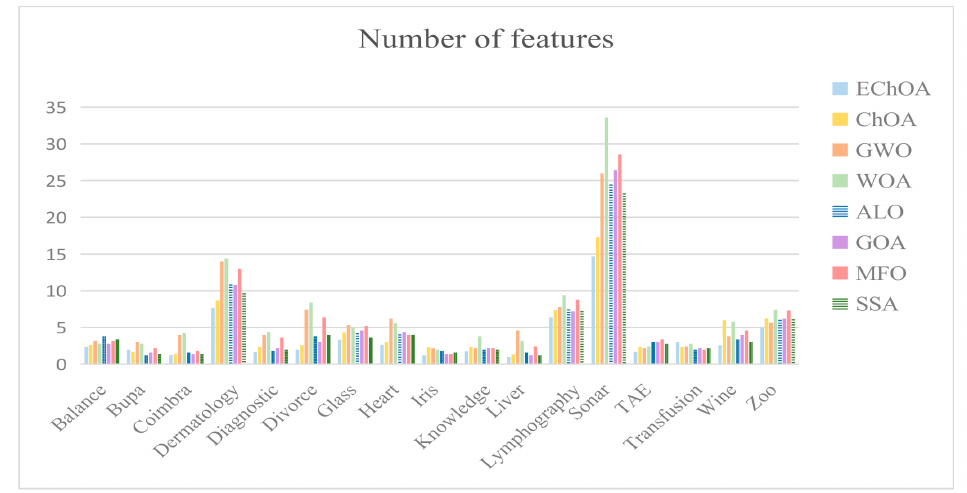
Figure 4. Histogram for the number of features of EChOA and other algorithms based on 17 data